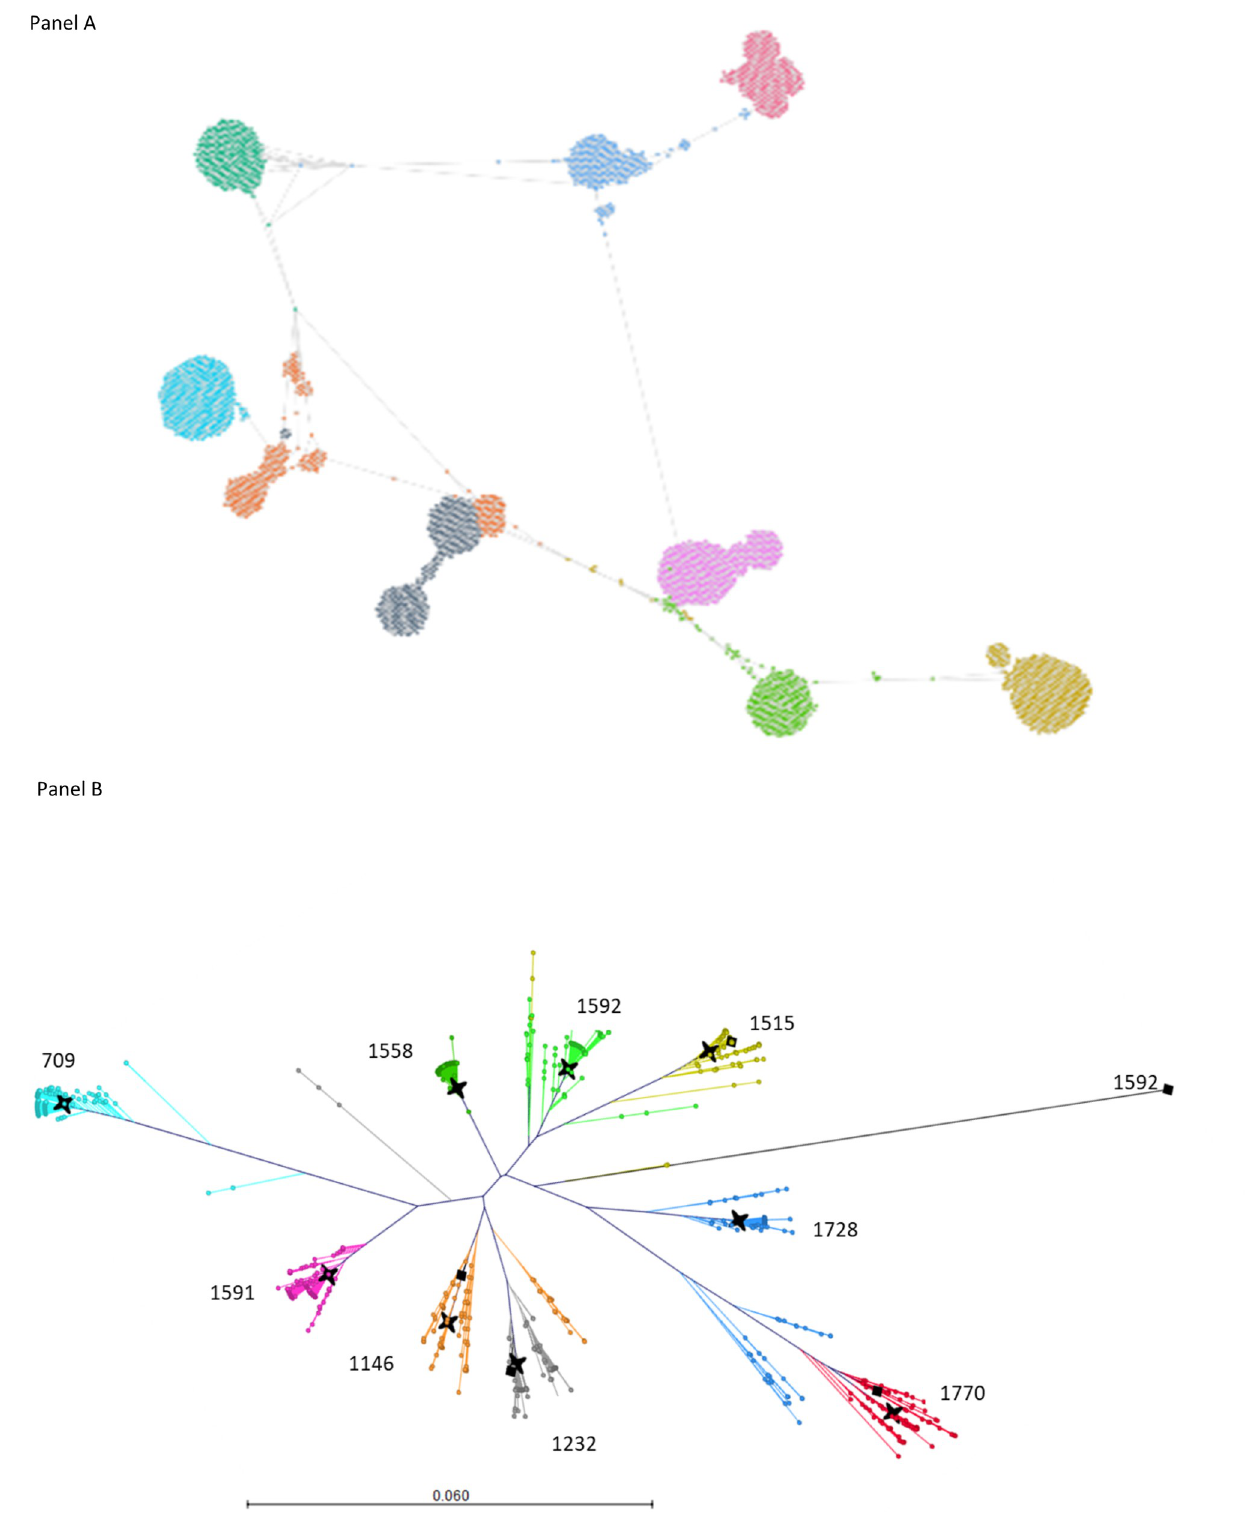
Fig 6. K step network (A) of the Sofia 1 cluster of transmission defined by threshold distance of 0. 037. Phylogenetic tree (B) of the Sofia 1 cluster with all haplotypes with frequency > 10. Sanger consensus sequences -black star; major sequence haplotype -black diamond. For cases 709, 1558, 1591 and 1728 the major coincided with the Sanger consensus; the coloring of the cases is the same for both panels. https://doi.org/10.1371/journal.pone.0212350.g006 PLOS ONE | https://doi.org/10.1371/journal.pone.0212350 March 5,